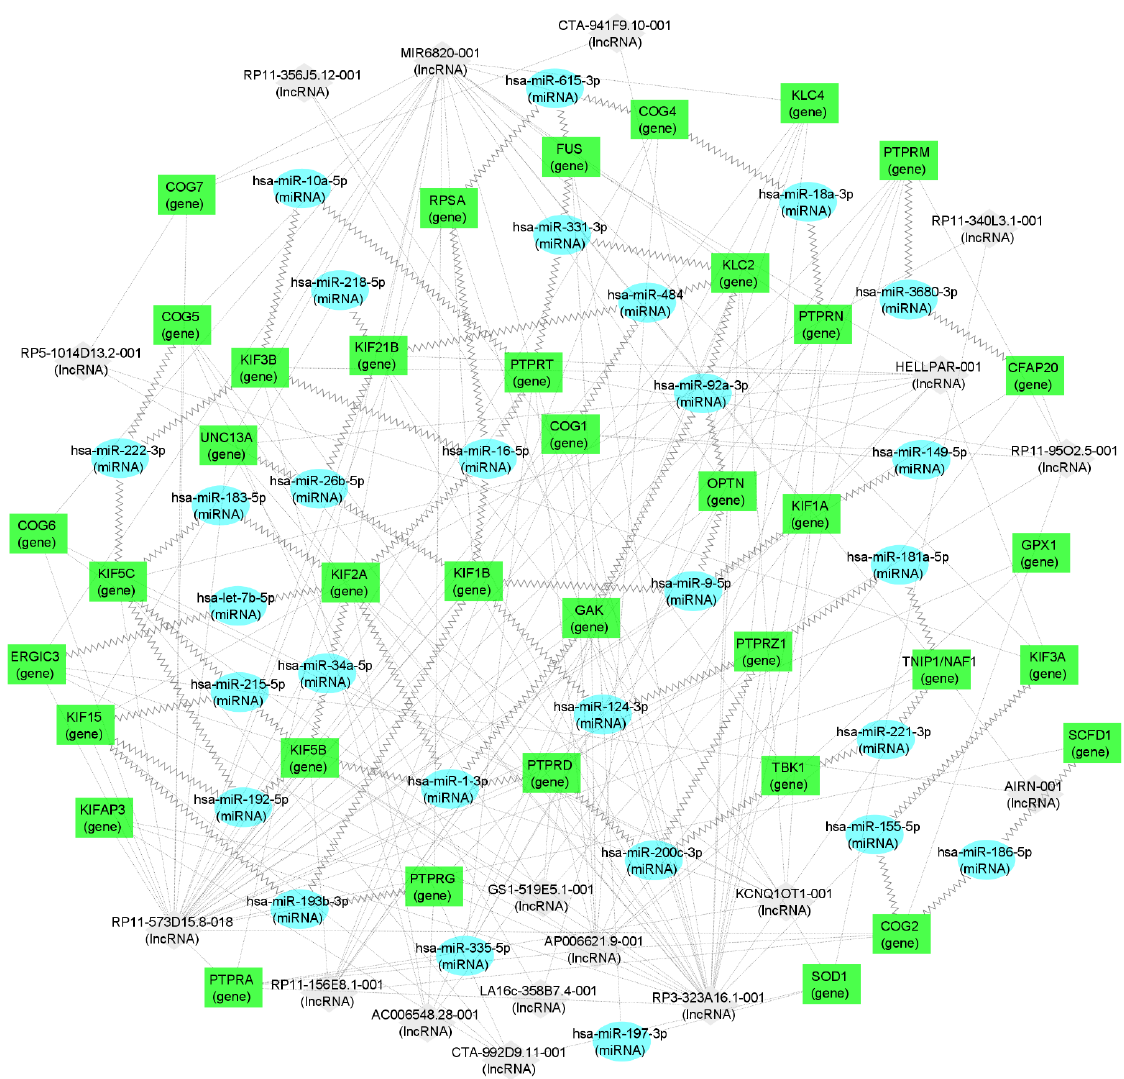
Figure 3. mRNA–miRNA–lncRNA network visualization. Green rectangles represent genes (i.e., mRNA), blue ellipses represent miRNA, and gray diamonds represent lncRNA. Jagged connections between RNA nodes represent interactions confirmed in whole blood while dotted lines represent interactions in different tissues. RNA nodes with fewer than two connections were not retained for visualization.